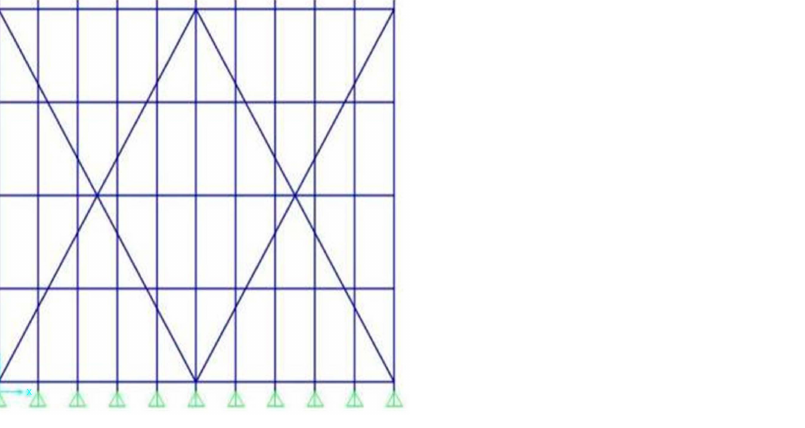
Figure 6. Finite element model of fastener steel tube formwork bracket: XZ plane.